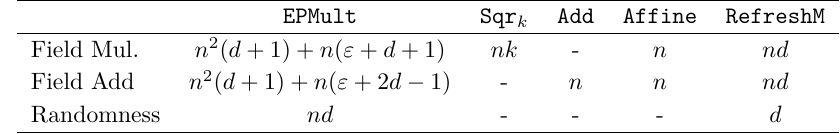
Table 2: Number of field multiplications, additions, and randomness requirements for the SMC operations. EPMult Sqr k Add Affine RefreshM Field Mul. n 2 ( d + 1) + n ( ε + d + 1) nk - Field Add